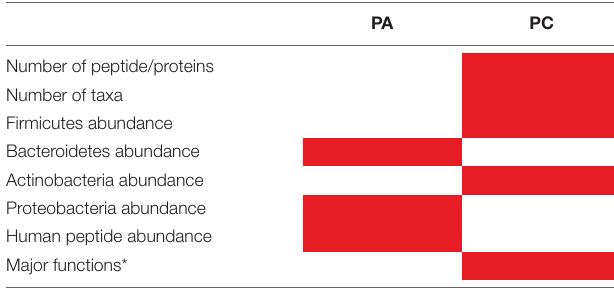
Red color indicates better result. *Major functions include three COG categories: “translation, ribosomal structure, and biogenesis,” “carbohydrate transport and metabolism,” and “energy production and